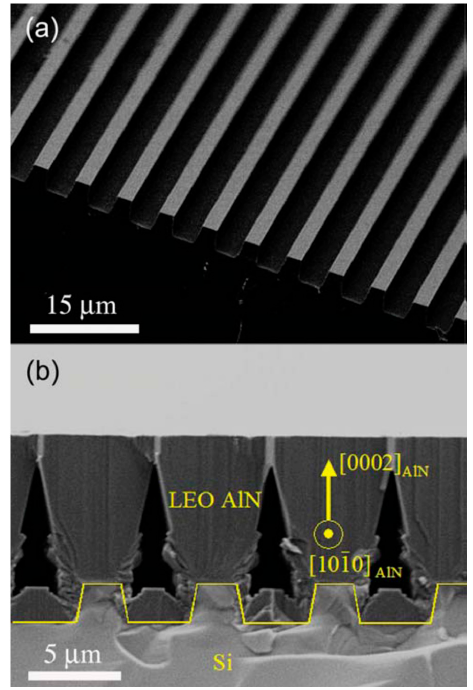
Figure 7. Scanning electron microscope (SEM) images of ( a ) perspective view of the stripe-patterned AlN/Si(111) template with nominally 3 μ m ridges and 3 μ m trenches (6 μ m period) and ( b ) cross- AlN/Si(111) template with nominally 3 µ m ridges and 3 µ m trenches (6 µ m period) and ( b